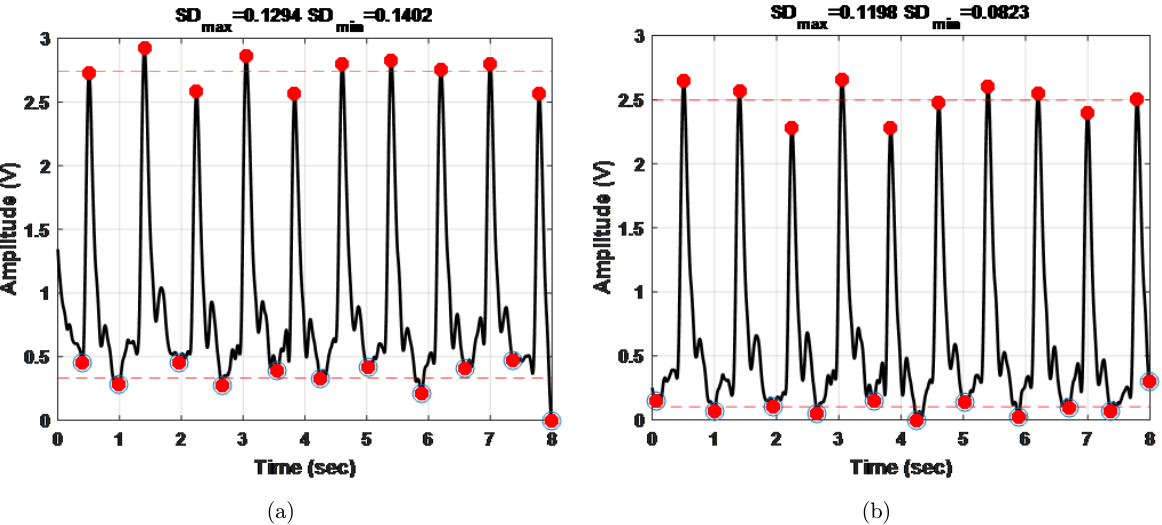
Fig. 12. Detection of PPG signal peak and valley points (a) Raw signal and their peaks (b) pre-processed signal and their peak values SD: standard